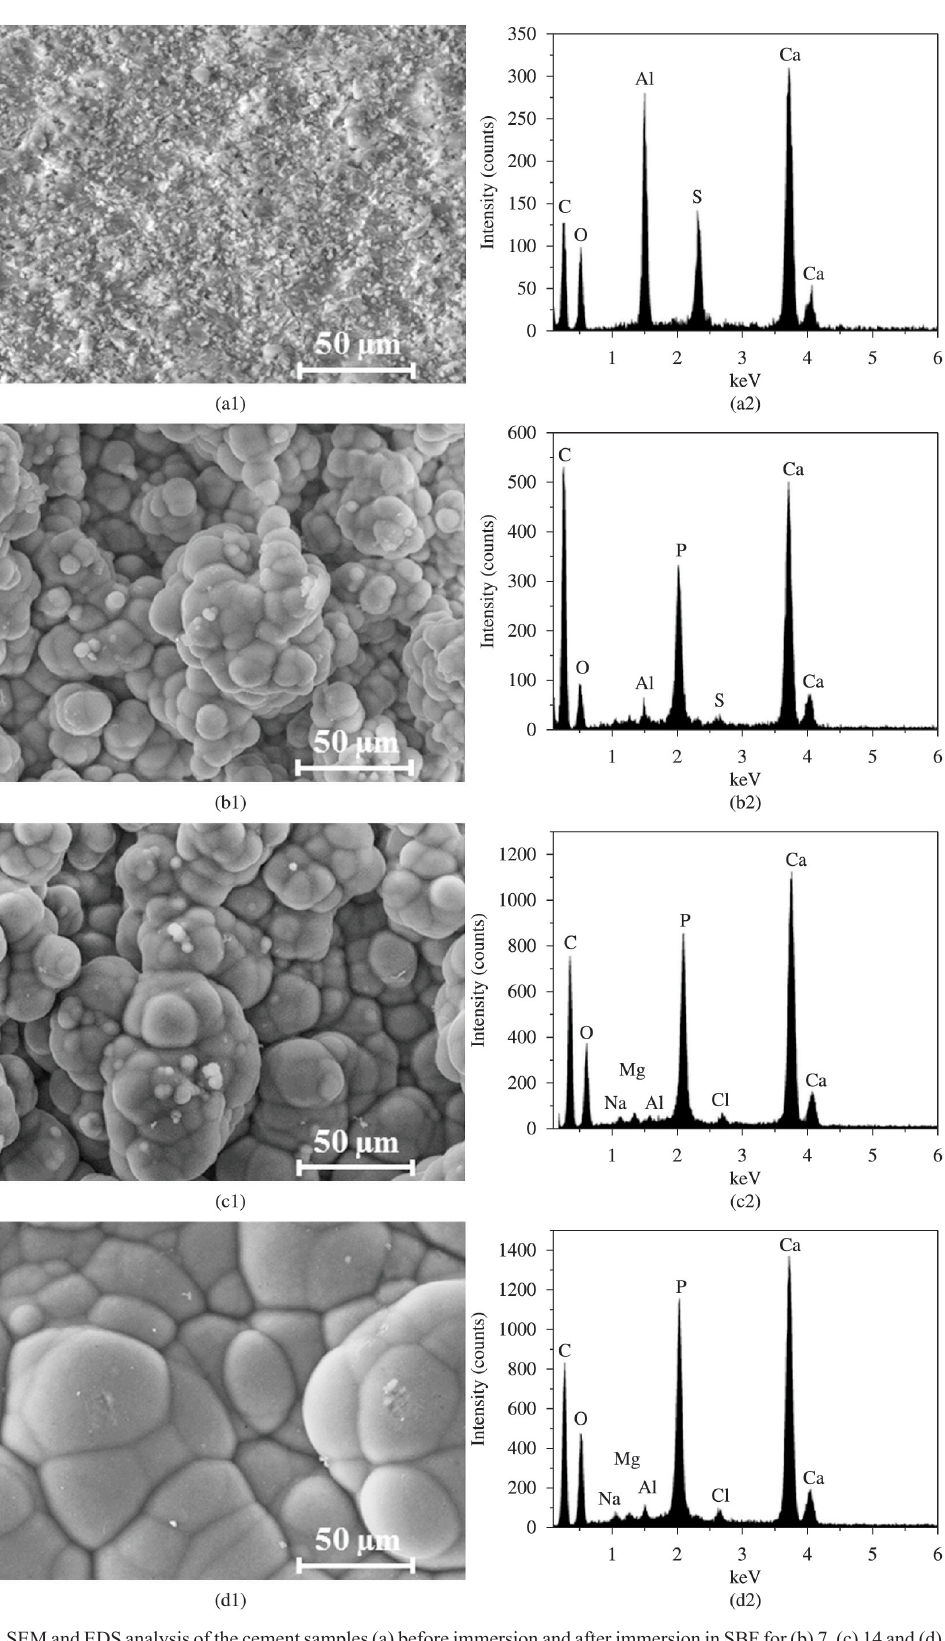
Figure 3. SEM and EDS analysis of the cement samples (a) before immersion and after immersion in SBF for (b) 7, (c) 14 and (d) 21